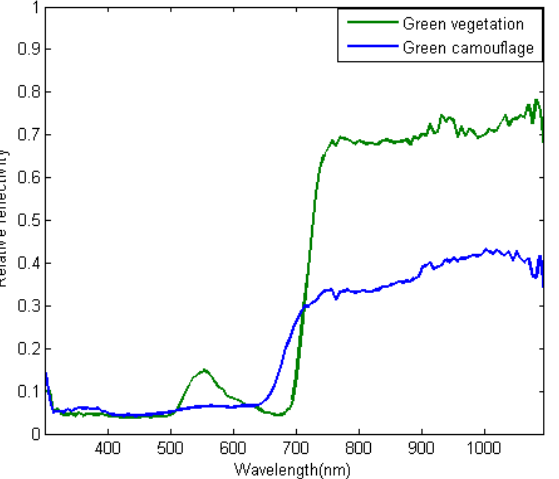
Figure 4. The spectral relative reflectivity of green vegetation and green